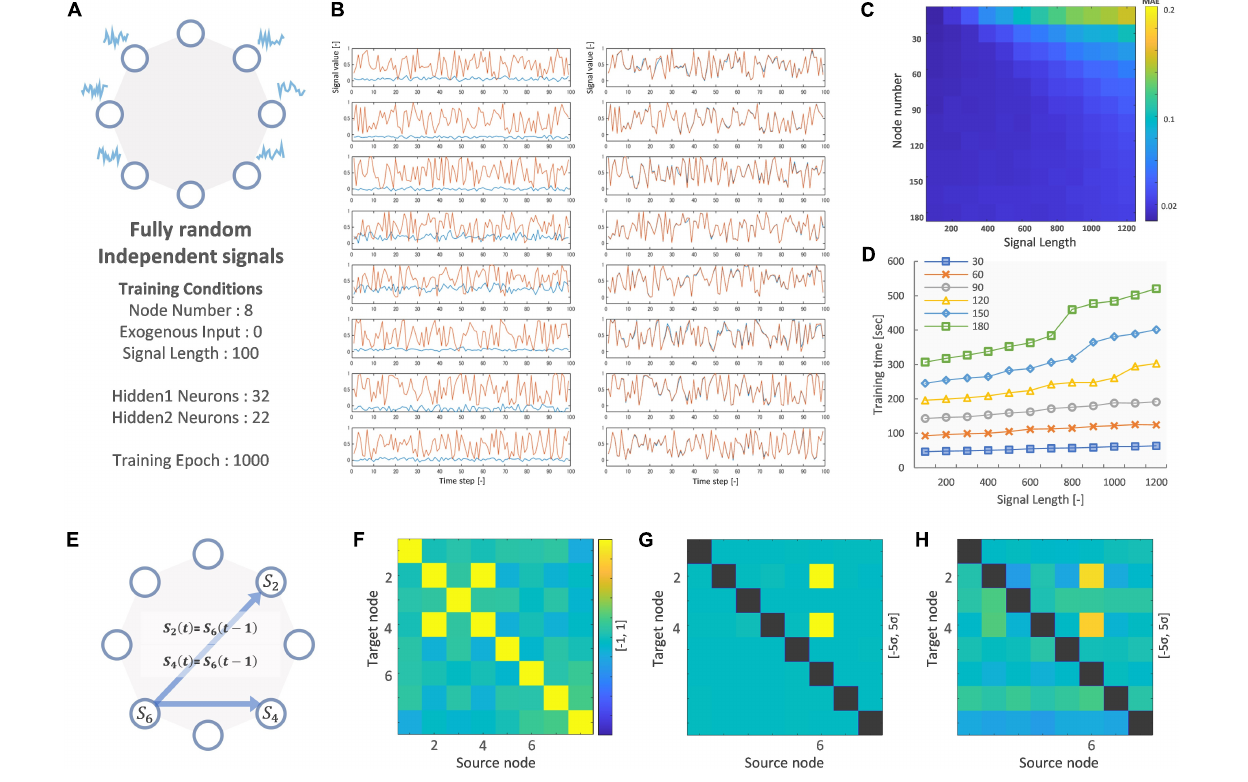
FIGURE 2 | (A) Node network image and training conditions. (B) Left shows before training signals of 8 nodes (Red: teaching signal, Blue: VARDNN output). Right shows after training signals. (C) Training error result (MAE) of signal length and node count. (D) Training time result of signal length and node count. (E) Node network image for evaluating FC, mvGC and VARDNN-GC. (F) FC result of E. Color range is [–1, 1]. (G) mvGC result of E. Color range is [ – 5 σ , 5 σ ]. (H) VARDNN-GC result of E. Color range is [ – 5 σ , 5 σ